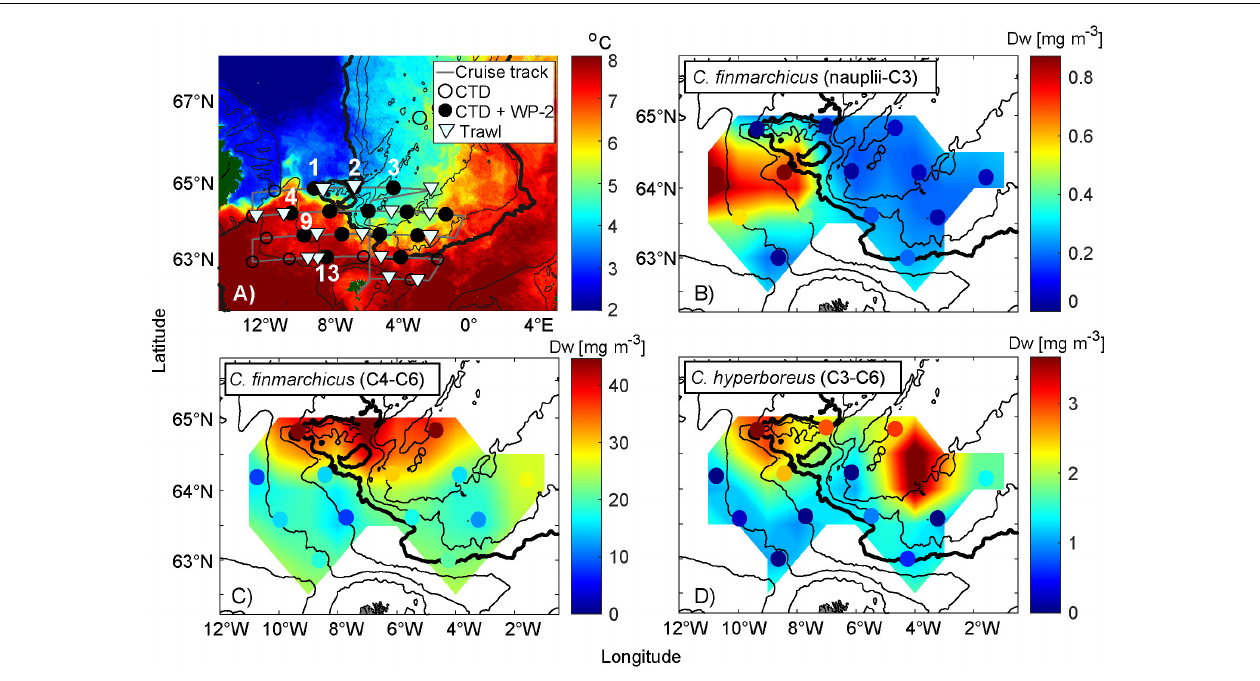
FIGURE 5 | Biomass distribution of Calanus spp. in relation to hydrographic conditions in May 2020. (A) Average satellite-based sea surface temperature from 30th April to 9th May, (B) biomass of Calanus finmarchicus developmental stages nauplii-C3 (dry weight, Dw), (C) Calanus finmarchicus C4–C6, and (D) Calanus hyperboreus . The colored dots represent the sampling position as well as actual value. Detailed information is displayed in (A) including the sampling positions of only CTD measurements (circled dots) and CTD measurements together with counted zooplankton data (black dots) and average trawling positions (triangles). The black dotted stations along the cruise track (gray) are numbered from left to right. The northernmost track line contains stations from 1 to 3. Below are stations 4–8, followed by stations 9–12. The stations along the southernmost track line include 13–14. Stations 1 and 2 in (A) are in a region of particular interest. The 200, 500, 1,000, 2,000 (bold), 2,500, and 3,000 m depth contours are shown. Note that the map scale in (A) is different from the other three subplots. The scales of Calanus spp. concentrations also